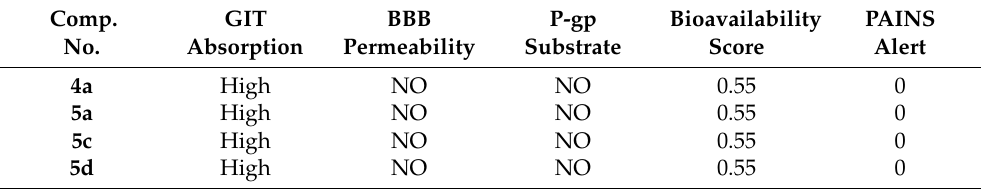
Table 6. Predicted pharmacokinetic properties of the most active new quinazolin-4(3 H )ones.